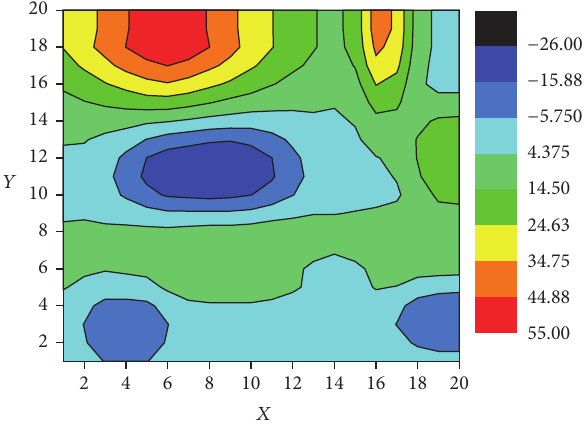
Figure 8: Digital profile of topographical surface.